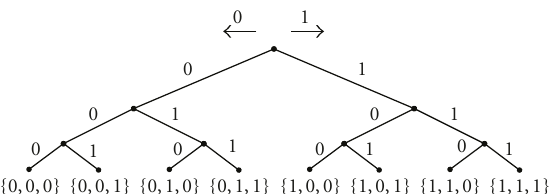
Figure 1: A depth-3 tree structure for an embedded quantization scheme. Indexes of terminal nodes, corresponding to initial code- words, are indicated below the